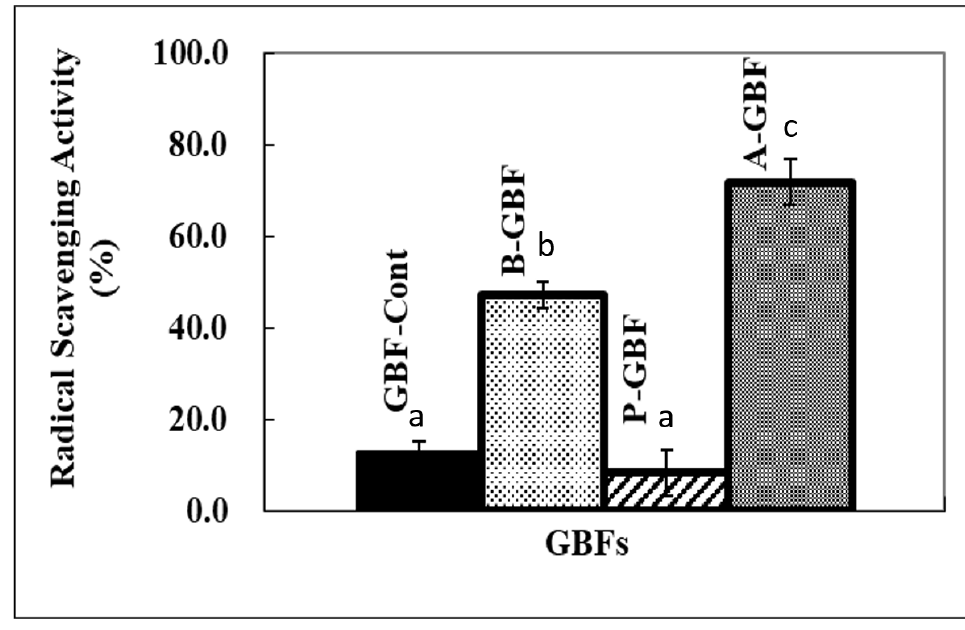
Figure 7. Radical scavenging activity of GBFs incorporating 1.0% antioxidants using DPPH free radical. Note that GBF-Cont represents pure GBF while A-, B-, and P- stand for ascorbic acid, BHA, and phytic acid, respectively. Bars indicate that the standard deviation and different letters (a, b, or c) are significantly different ( p < 0.05).